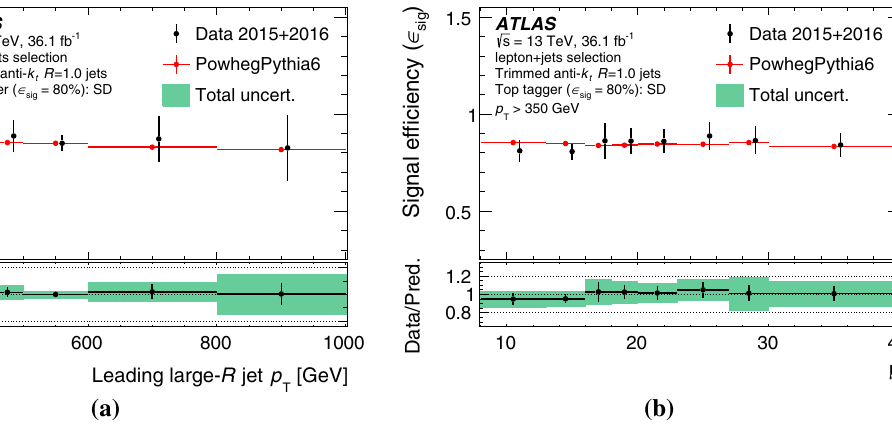
Fig. 22 The signal efficiency on contained top-quark jets for the Shower Deconstruction top-quark tagger as a function of the large- R jet p T ( a ) and the average interactions per bunch crossing μ ( b ) in data and simulation. Statistical uncertainties of the signal efficiency measure- ment in data and simulation are shown as error bars in the top panel. In the bottom panel, the ratio of the measured signal efficiency in data to